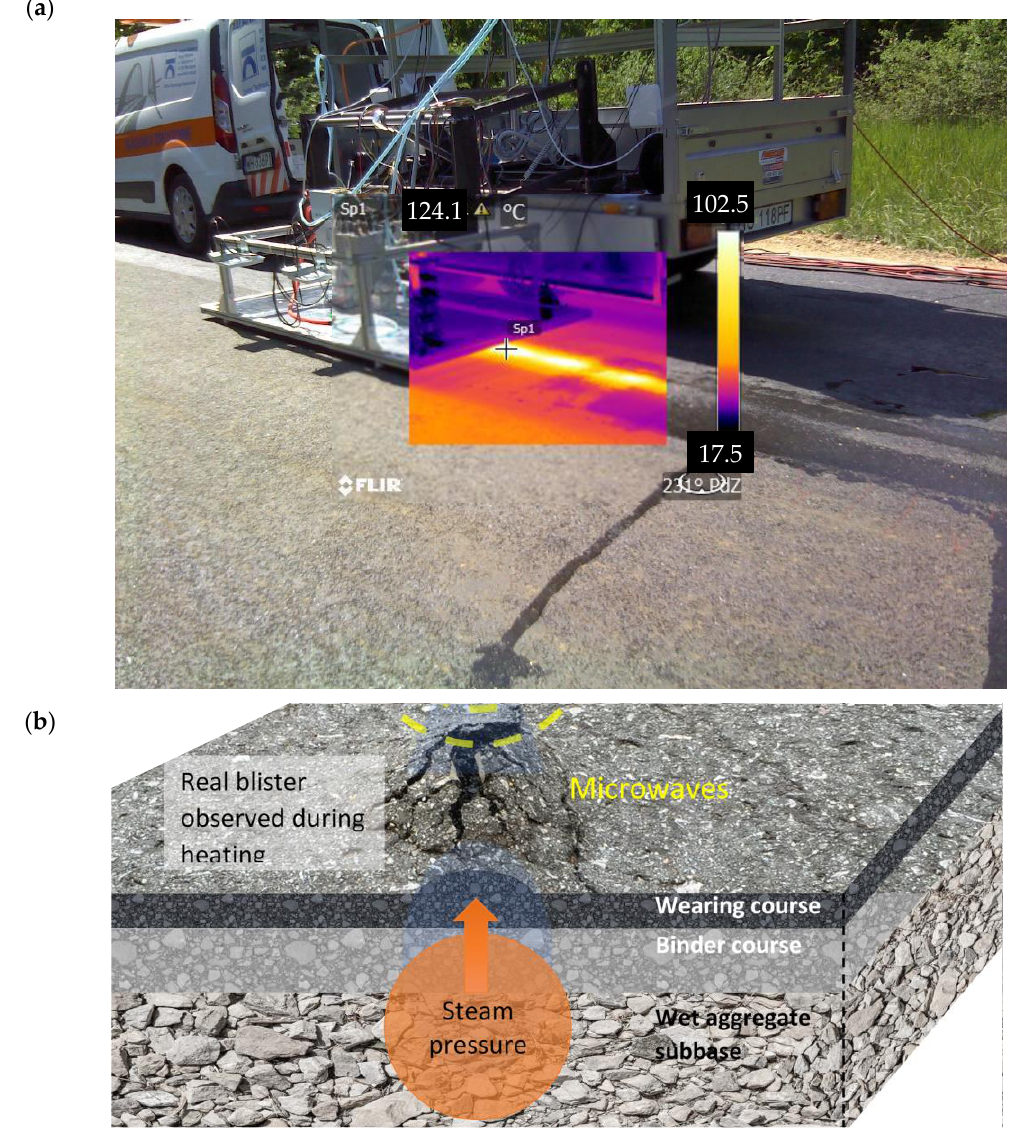
Figure 4. ( a ) Thermal effect of pavement heating using microwave applicator; ( b ) Blistering phenomenon during heating of asphalt.